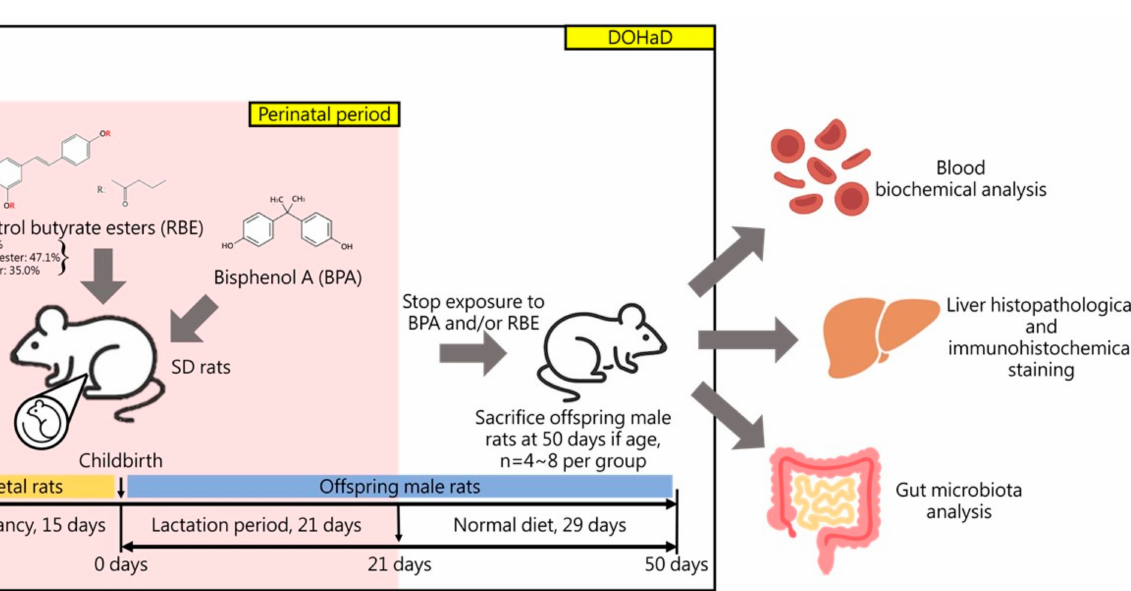
Figure A1. The graphical abstract of this